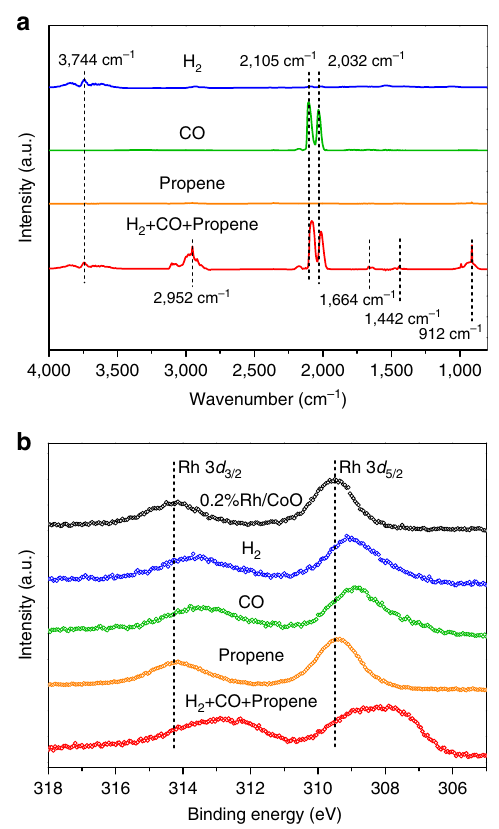
Figure 3 | The interaction between reactants and 0.2%Rh/CoO. ( a ) In situ DRIFT spectra of 0.2%Rh/CoO after the treatment of the sample with different gas at 100 (cid:2) C. The peak at 3,744cm (cid:2) 1 corresponds to the stretching vibration of –OH group; the peaks at 2,105 and 2,032cm (cid:2) 1 correspond to the stretching vibrations of CO adsorbed on Co and Rh atoms, respectively; the peaks at 2,952, 1,664, 1,442 and 912cm (cid:2) 1 correspond to the stretching vibration of C-H, the stretching vibration of C ¼ C, the scissoring vibration of C–H, and the bending vibration of C–H in propene, respectively. ( b ) In situ XPS spectra of 0.2%Rh/CoO before and after the treatment of the sample with different gas at 100 (cid:2)